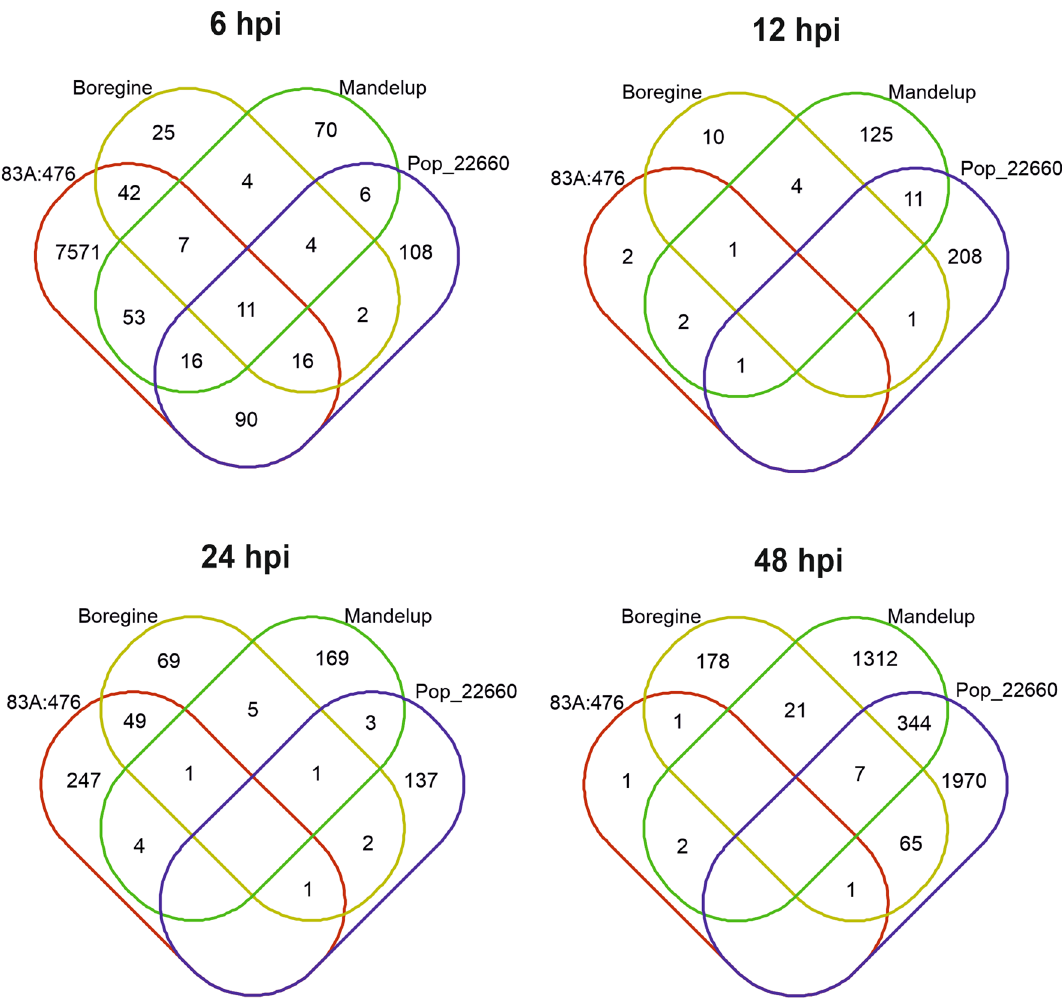
Figure 1. Venn diagrams showing the number of differentially expressed genes (DEGs) in narrow-leafed lupin (NLL) lines subjected to Colletotrichum lupini inoculation (strain Col-08, obtained in 1999 from the lupin field in Wierzenica, Poland). Analyzed NLL lines were as follows: 83A:476 (resistant, carrying the Lanr1 allele), Boregine (resistant, unknown genetic background), Mandelup (moderately resistant, carrying AnMan allele) and Population 22660 (very susceptible). Abbreviation hpi stands for hours post inoculation. To simplify diagrams zero values were removed.